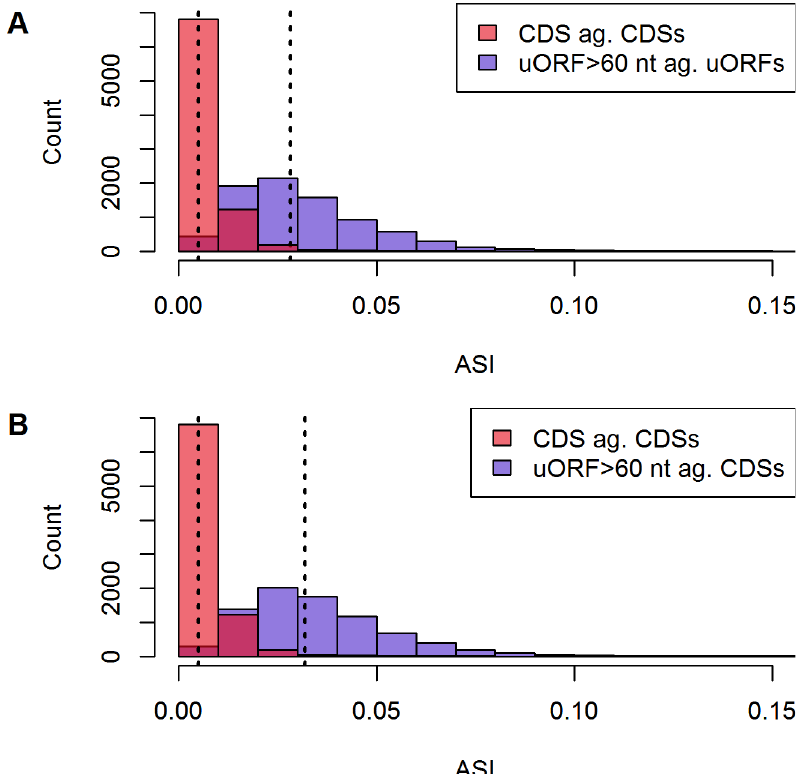
Fig 3. ASI CDS against CDSs and uORF > 60 nt ag. uORFs and CDSs. Due to the extensive length bias, ASIs are only calculated for uORFs longer than 60 nt. CDSs and uORFs present significantly different distributions of ASI (non- paired Wilcoxon test, p < 0.05, p < 0.05). Median (dashed lines) ASI for uORFs against uORF background and CDSs is 0.0281 and 0.0050, respectively ( A plot). uORF ASI against CDSs achieves a higher median than calculation against the intrinsic subset (0.0319, B plot). Additionally, uORF distribution comprises a broader range of ASIs than CDSs. CDSs employ a distinct set of amino acids, while uORFs display larger variability, still including some sequences with highly optimized ASIs. Calculation of uORF ASI against CDSs reveals the disparity of both subsets. (n CDS = 8,345, n uORF = 8,156).